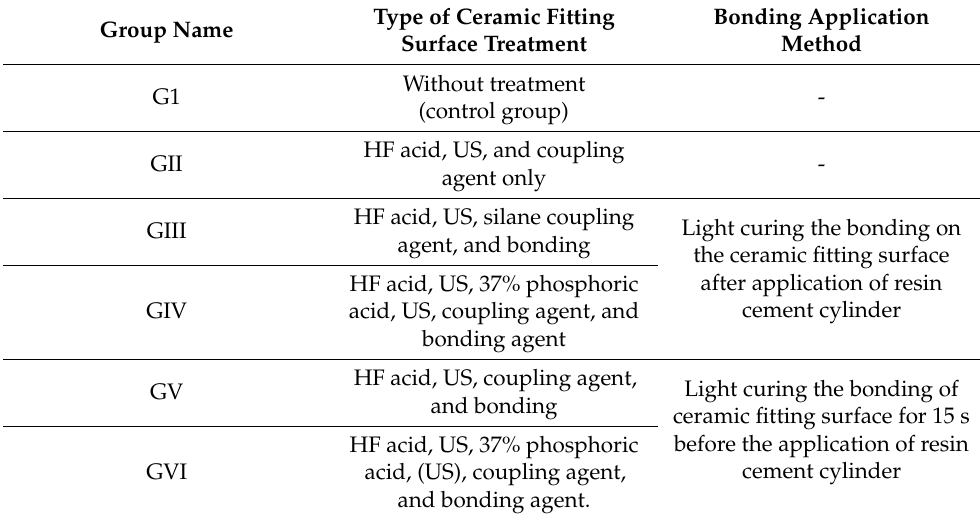
Table 2. Treatments of ZLS were applied to study